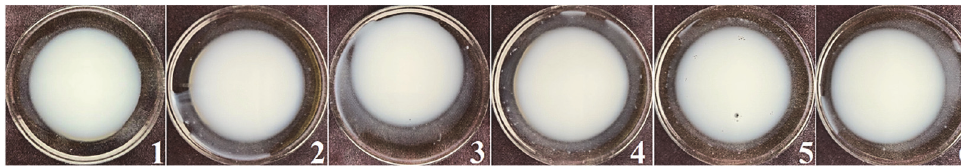
Table 2. Characterization results of nanoemulsions.